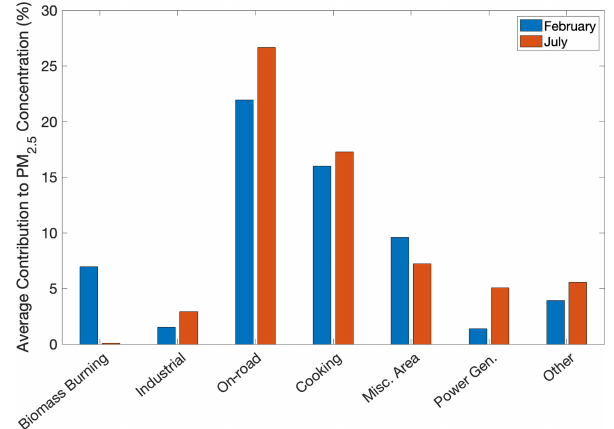
Figure 9. Relative contributions of local sources to average pre- dicted total PM 2 . 5 concentrations in the inner 1 × 1km resolution domain during February and July 2017.